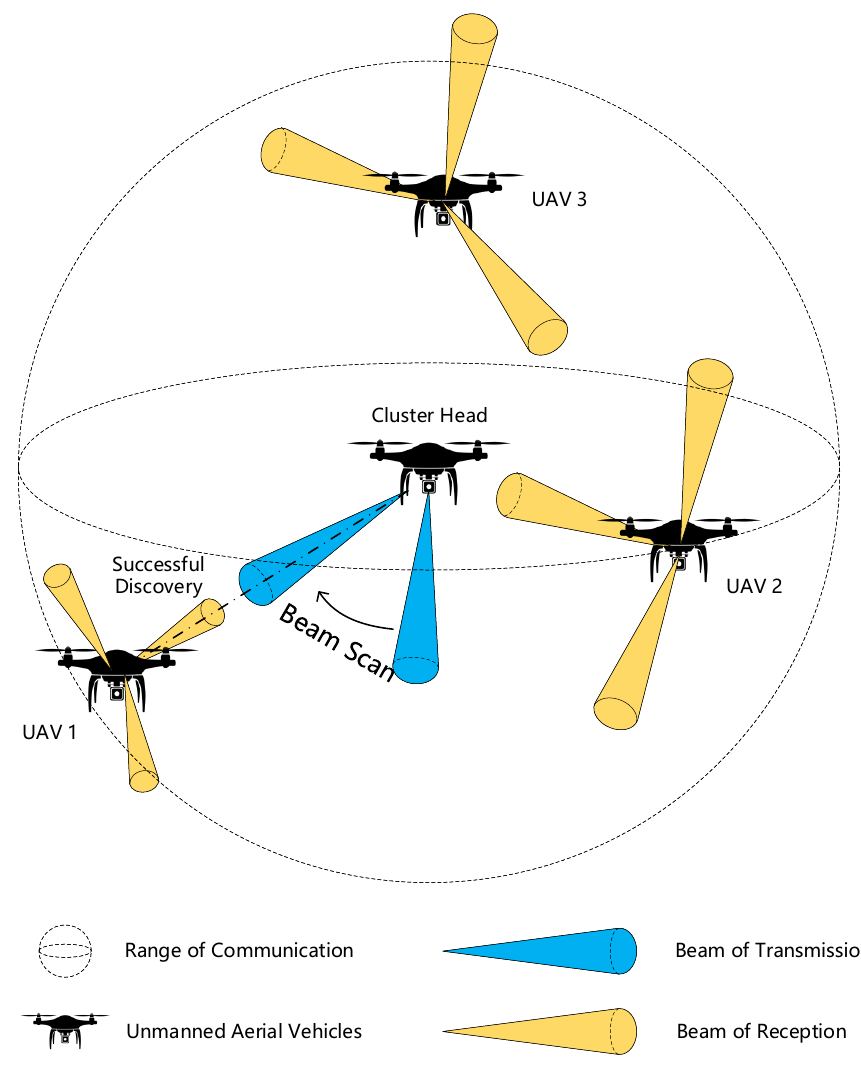
Figure 3. Neighbor discovery in sector